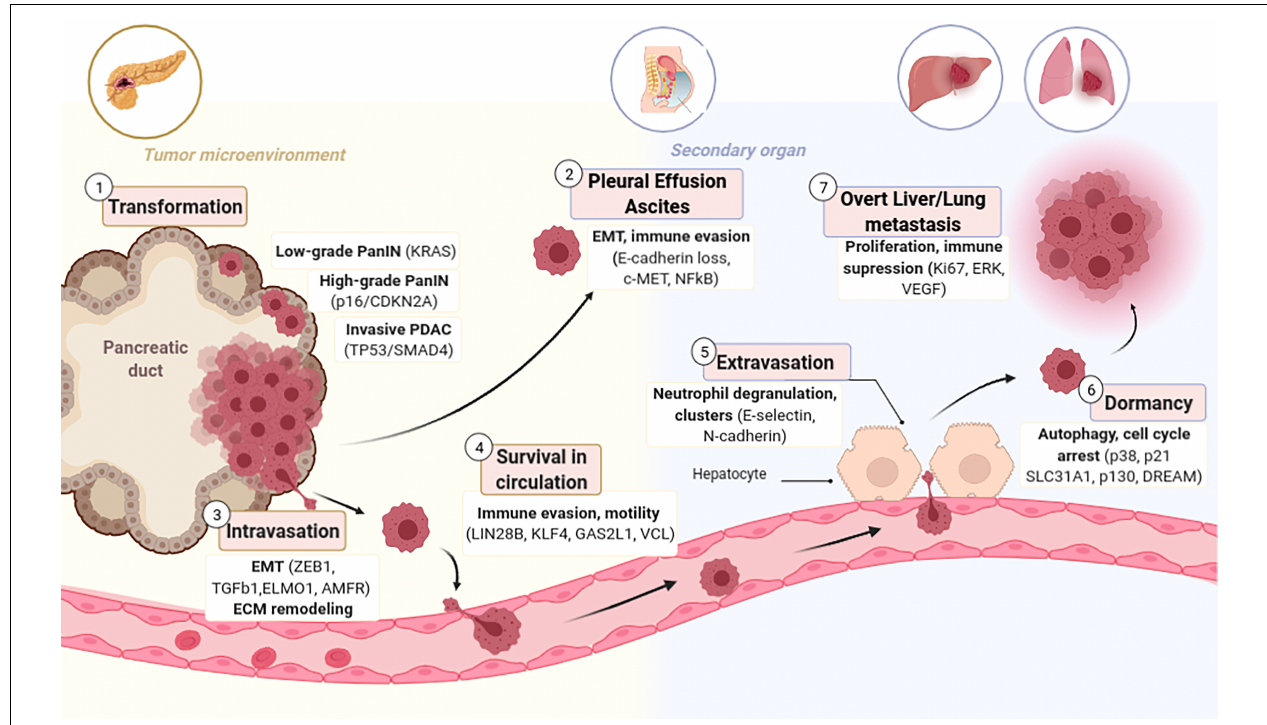
FIGURE 1 | Stages of Metastatic Progression with candidate genes responsible per each stage. (1) Normal epithelial pancreatic ductal cells acquire an aggressive phenotype through serial mutations that transform them firstly to PanIN and lately to PDAC. (2) Transformed cells are capable of detaching and colonizing the Peritoneum forming Ascites or Pleural Effusion. (3) PDAC cells have enhanced motility due to EMT that allows them to invade blood or lymphatic vessels. (4) CTCs in circulation are abundant, but only few survive this pressure. (5) Several CTCs have tropism for the pre-metastatic niche (PMN) and are able to extravasate to a secondary organ where they might remain dormant (6) for several years and eventually relapse and form overt metastasis